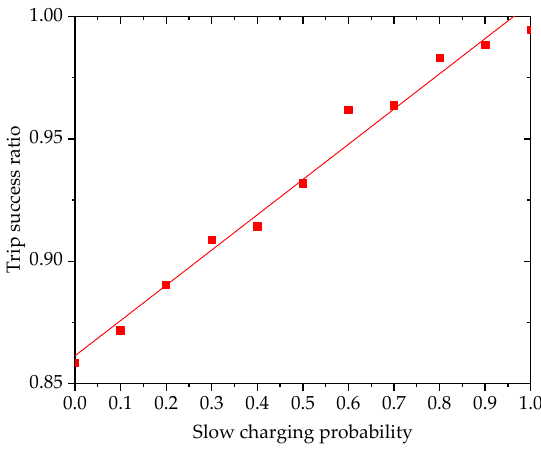
Figure 21. The travel success ratio under different slow charging probabilities.